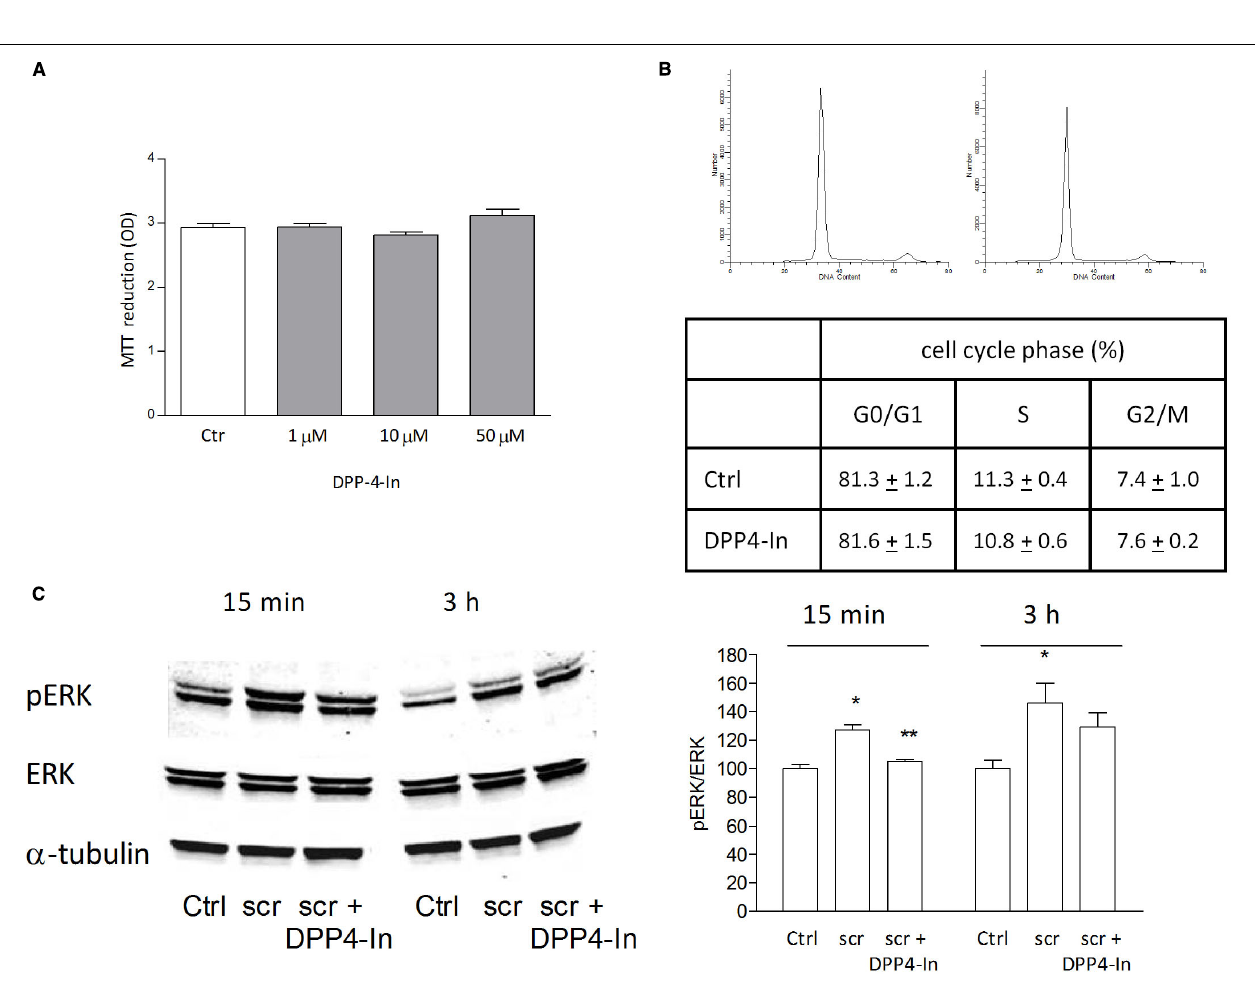
FIGURE 3 | The healing promoting effect of DPP4-In does not involve increased cell proliferation. Treatment with increasing concentrations of DPP4-In does not modify cell proliferation as from MTT assay (A) . Cell cycle analysis of NCTC 2544 cells treated with DPP4-In (10 m M) for 24 h does not modify the distribution of cells in different phases of cell cycle, as by flow cytometry after labeling of cells with propidium iodide. In (B) , representative profiles of control (left panel) and DPP4-In (right panel) treated cells.